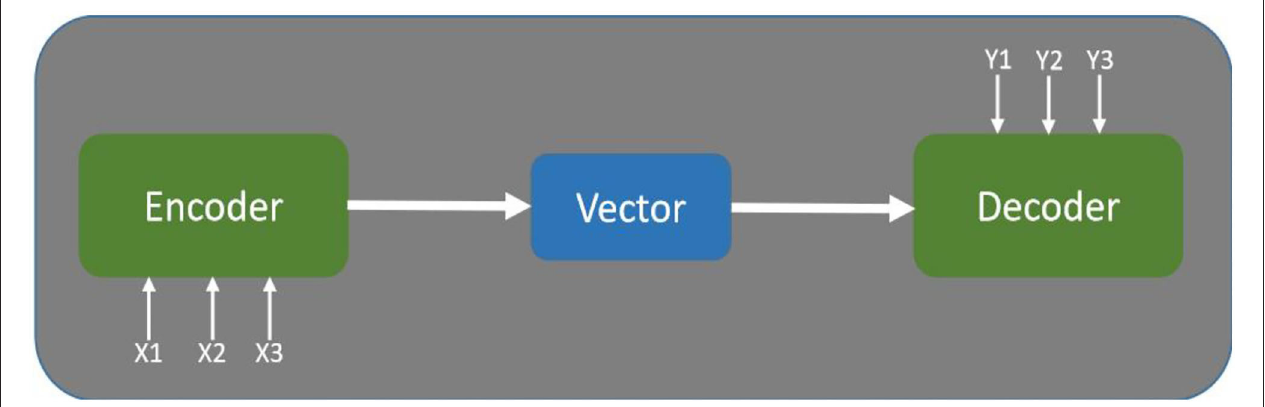
FIGURE 4 | Encoder-decoder